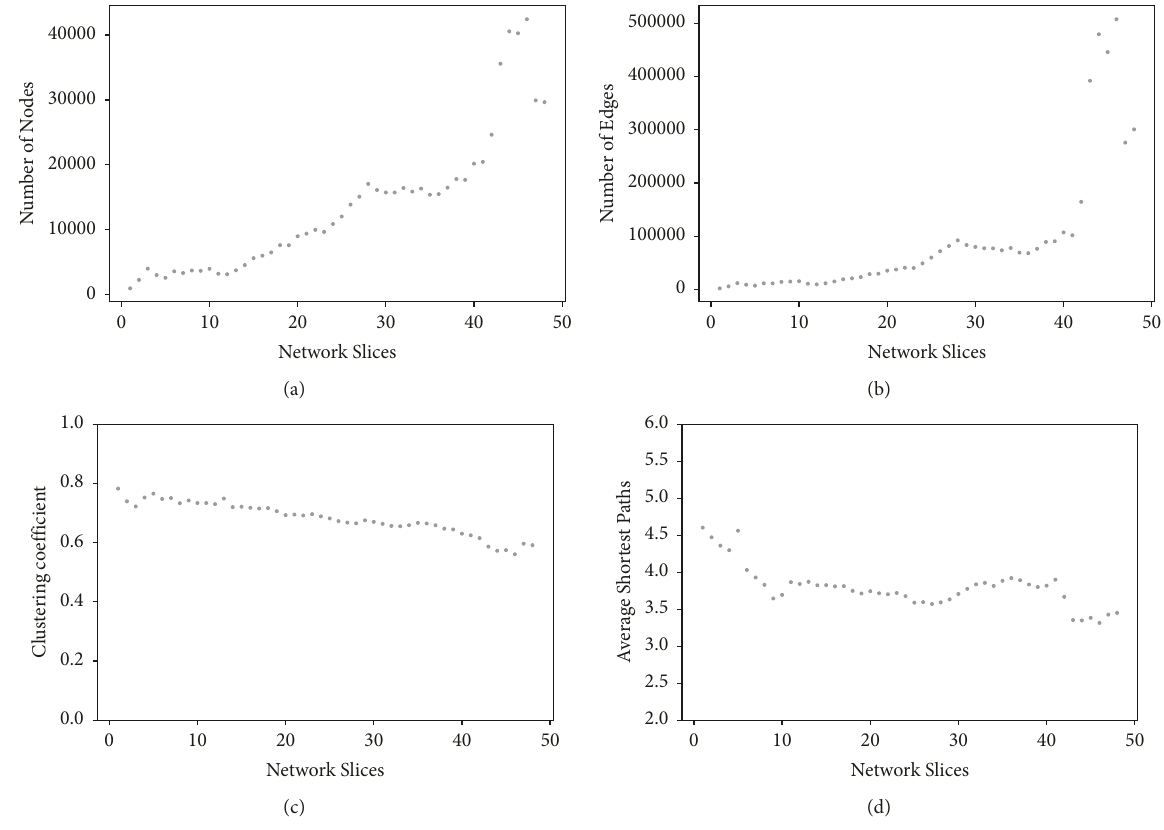
Figure 3: The characteristics of network slices: (a) the number of nodes, (b) the number of edges, (c) the clustering coefficient, and (d) the average shortest path of the largest connected component.